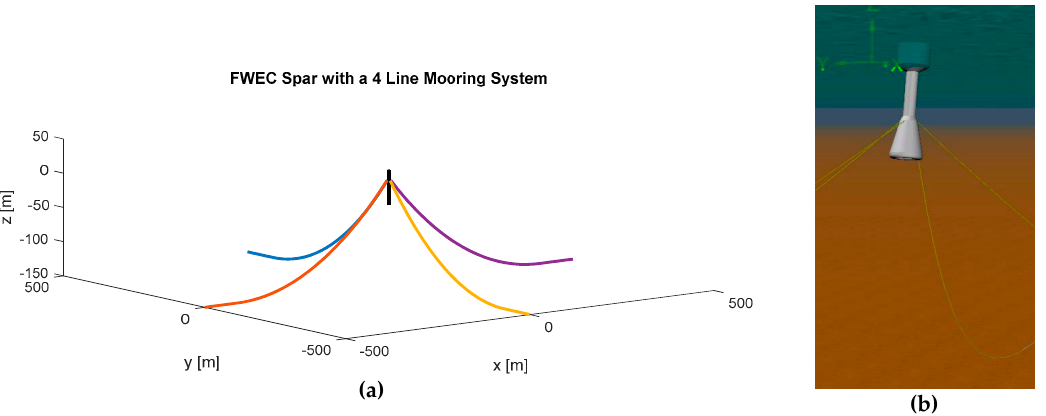
Figure 3. Four lines mooring system configuration modeled for both structures in 150 m water